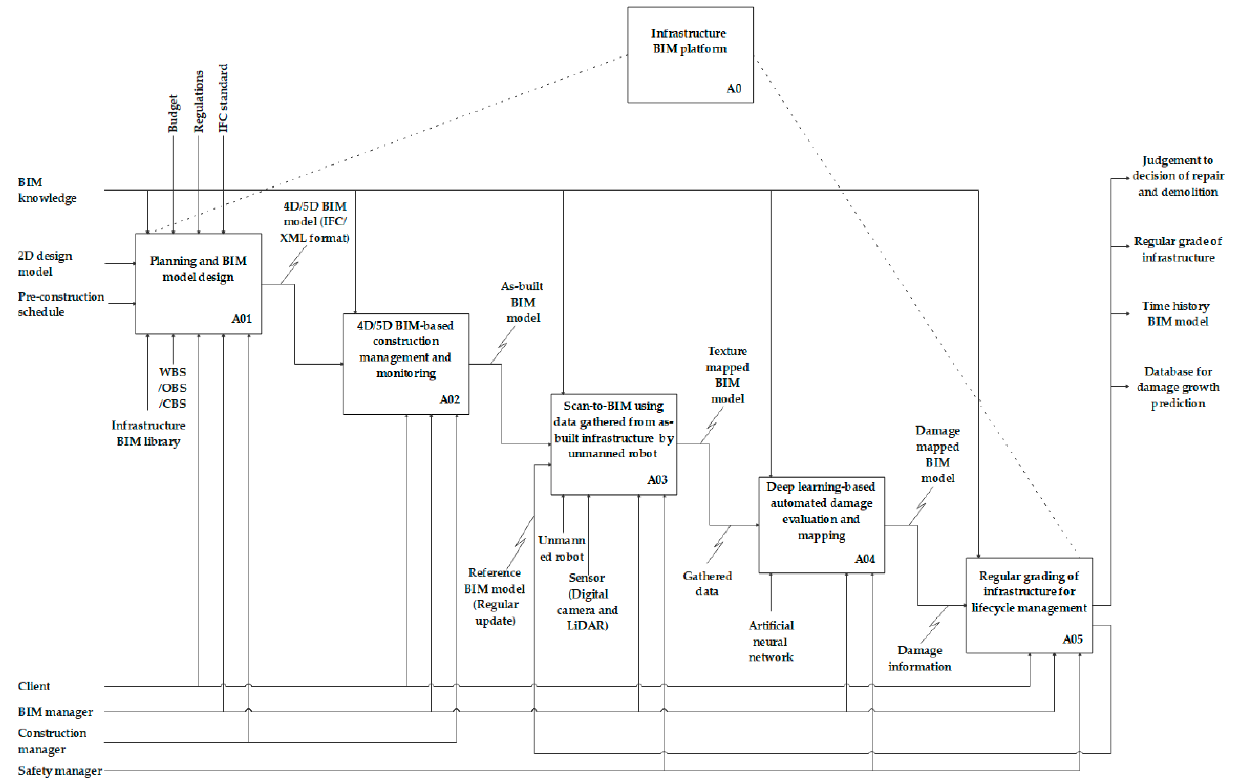
Figure 2. IDEF0 diagram of the infrastructure BIM platform.